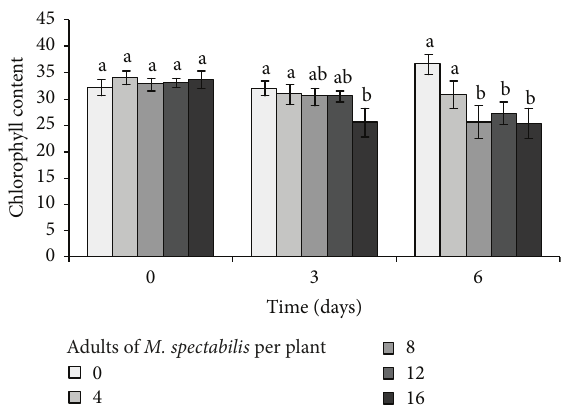
Figure 2: Relationship between chlorophyll content (SPAD unit) of B. ruziziensis and exposure time (0, 3, and 6 days) at different infestation levels of adult M. spectabilis . Mean values followed by the same letter within the levels of infestation did not differ by Tukey test.